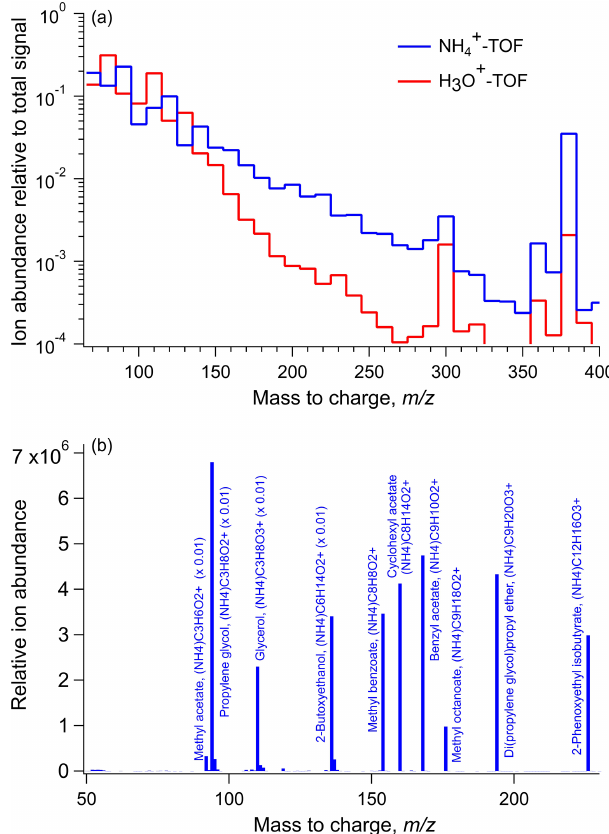
Figure 2. (a) Negligible parent ion fragmentation (with high signal to noise ratios) across diverse chemical functionalities in CI-ToF al- lows for measurements of understudied chemical species (examples from authentic standards shown). (b) Average ToF mass spectra ob- tained from NH + and H 3 O + (i.e., PTR) ionization schemes binned 4 over 10 m/z intervals using data from the same Vocus CI-ToF at the site. The CI-ToF spectra observed greater ion signal in the ap- proximate intermediate-volatility into the semi-volatile region (e.g., ≥ 160 m/z ). Note: in (b) , the NH + and PTR signals are offset by 4 18 and 1 m/z , respectively, to account for the difference in the mass of the reagent ion and the averages are from different days when the reagent ion was